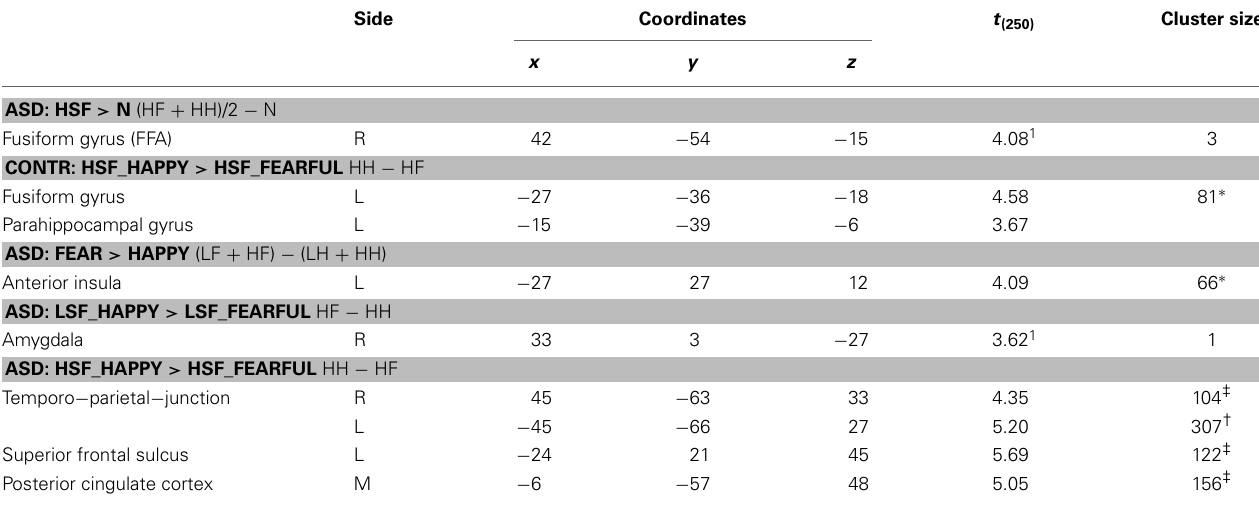
Table 4 | fMRI analysis: regions showing significant activation associated with the passive viewing sessions. Side Coordinates t (250) Cluster size x